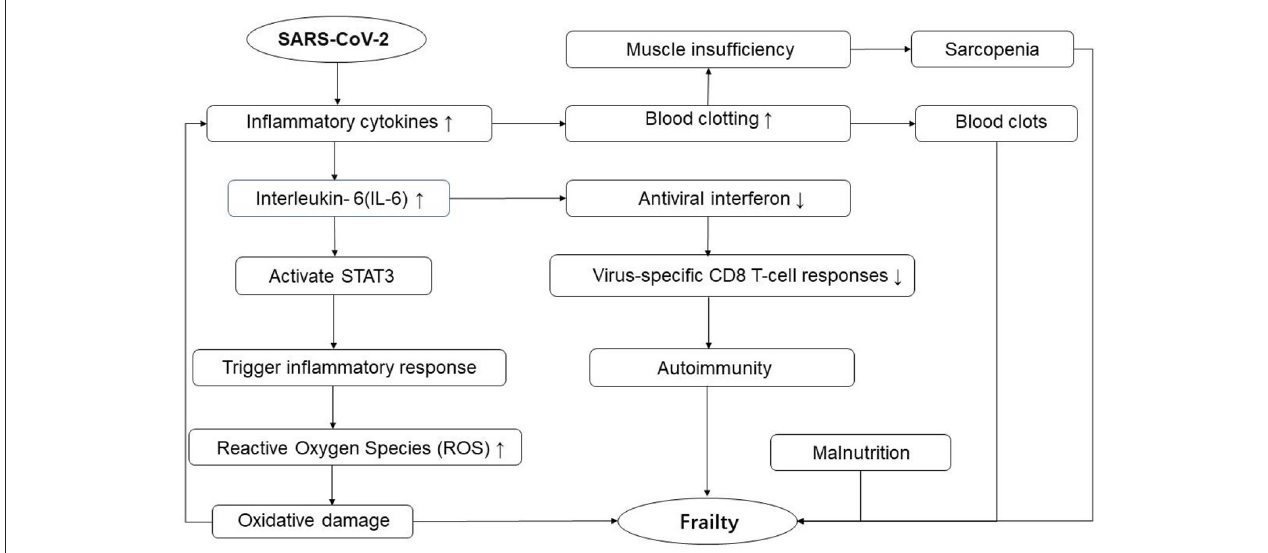
FIGURE 1 | Potential pathogenesis of frailty in elderly patients with